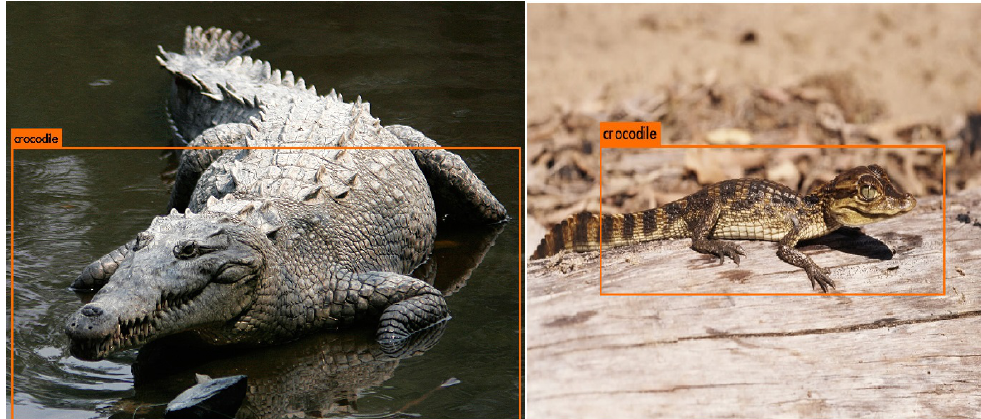
Figure 15. Occurrences of the real crocodile classification [59,60].